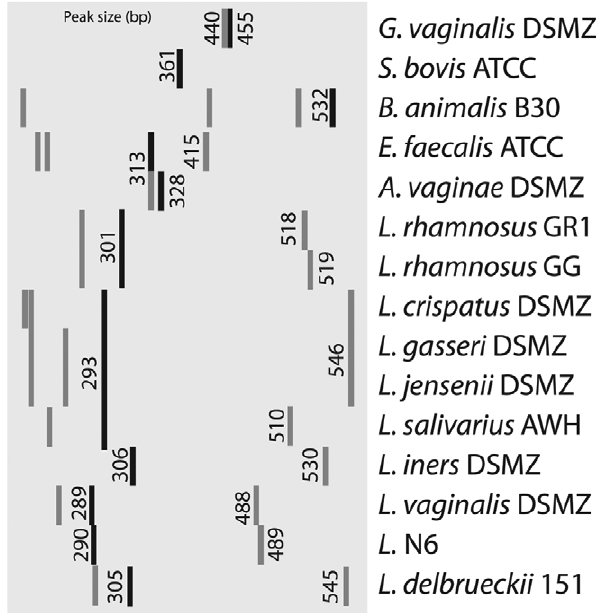
Figure 6. ISR profile for selected panel strains. ISR profiles for panel strains and isolates. The size (number of base pairs) for most major and minor amplicons is shown. Profiles were visualized using Java TreeView v 1.1.4r3. L.=Lactobacillus, E.=Enterococcus, A.=Atopobium, S.=Streptococcus, G.=Gardnerella, B.=Bifidobacterium .